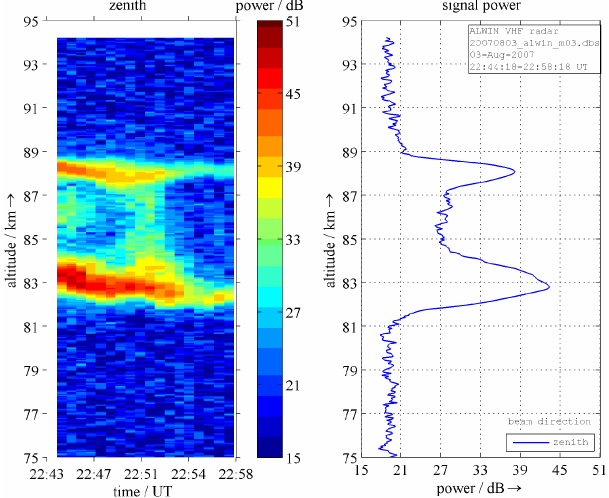
Fig. 2. ALWIN radar data for 3 August 2007 flight. T-0 was 22:51UTC. Data and plot from Ralph Latteck at the Leibniz-Institut f¨ur Atmosph¨aren Physik.